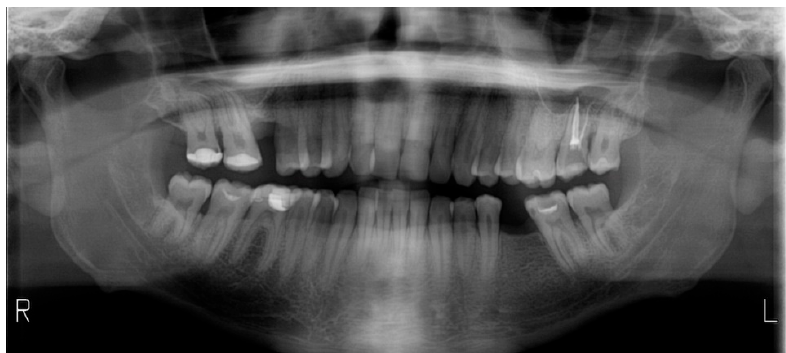
Figure 13. Case 2: orthopantomography.